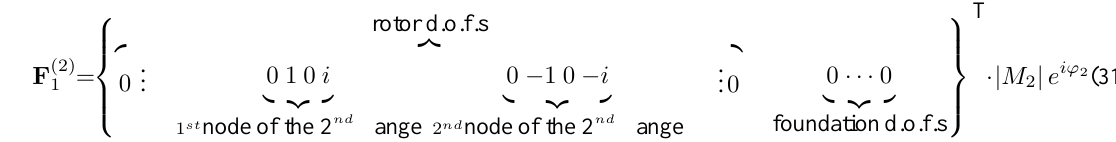
Fig. 11. Bode plot of the 1X transient vibrations X = X ref + X 1 induced on bearing #2 by the identified bending moments and the machine residual unbalance. Vibrations estimated by means of the simulating model. Machine trip level is 180 µ m pk-pk.